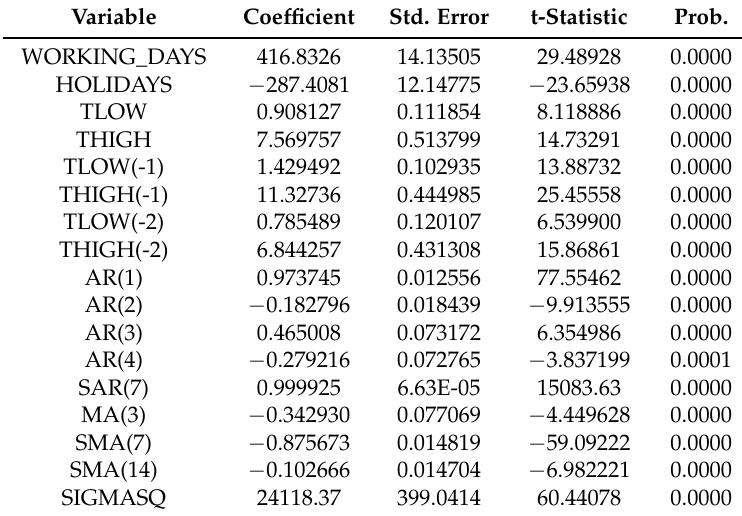
Table 5. SARIMAX model parameters for estimation set in the time period 2004–2013.